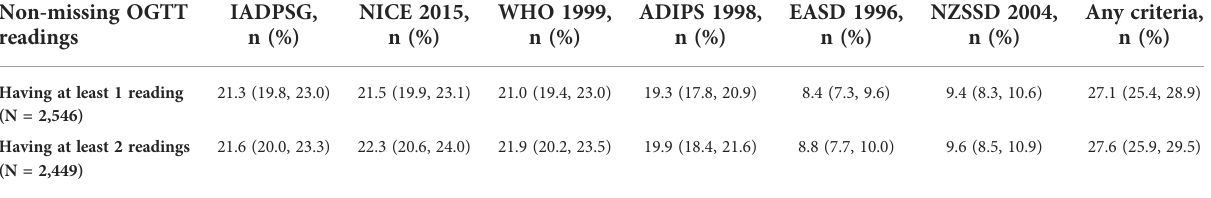
TABLE 6 GDM criteria-speci fi c cumulative incidence strati fi ed by the number of OGTT readings used for diagnosis. Non-missing OGTT readings Having at least 1 reading (N =